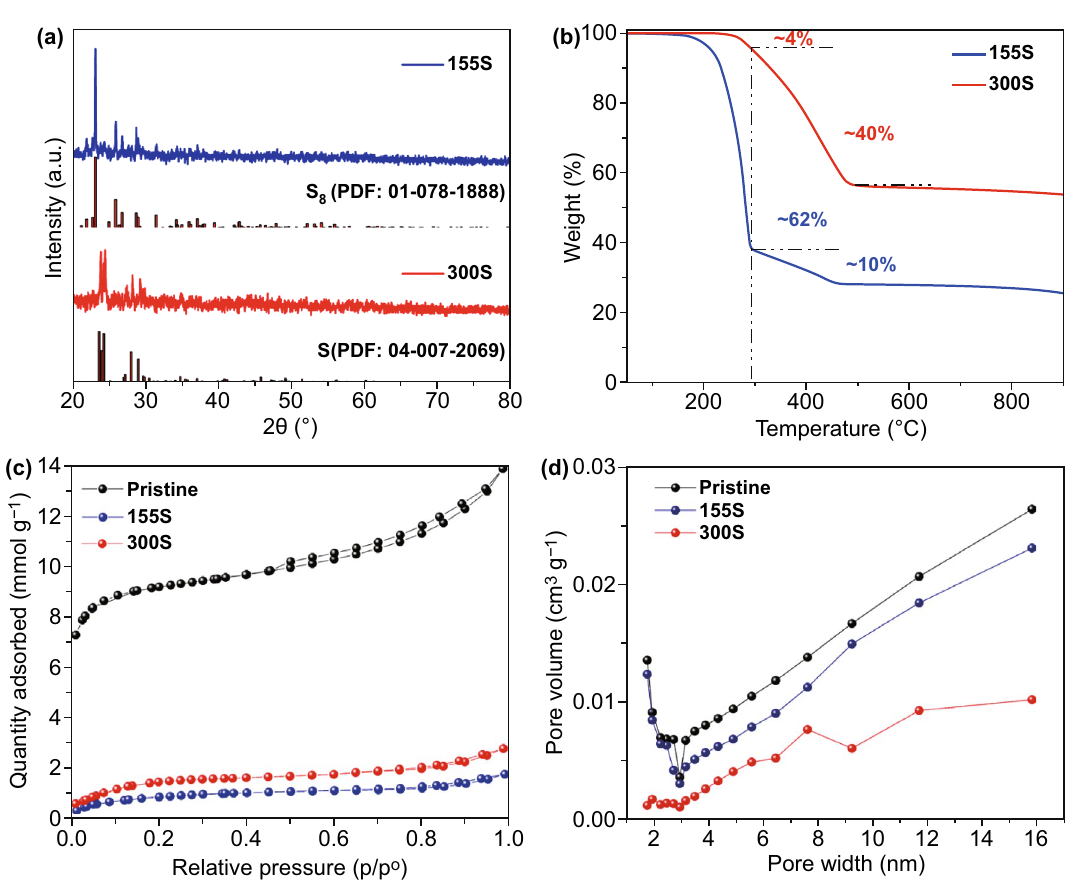
Fig. 2 a XRD patterns of the 155S and 300S. b TGA curves of the 155S and 300S. c BET isotherms of the pristine carbon host, 155S, and 300S. d Pore dispersions of the pristine carbon host, 155S, and